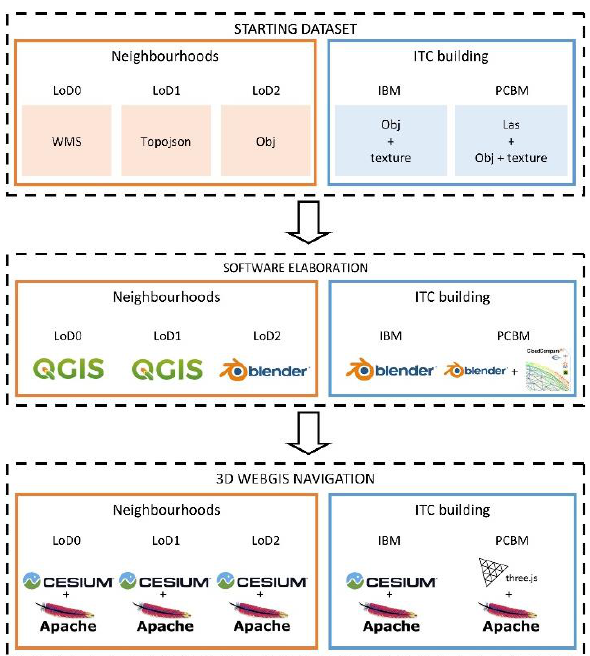
Figure 1 . The schema of the dataset and the open-source solutions involved in the